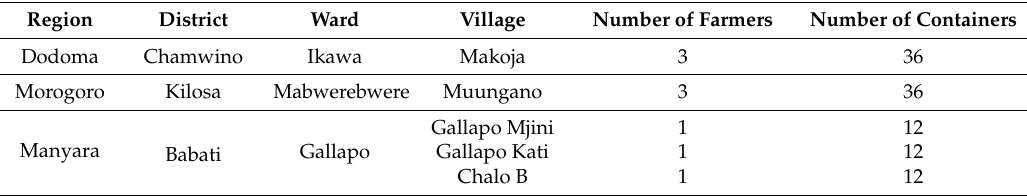
Table 2. Initial numbers of S. zeamais in each region per 0.5 kg of infested maize.